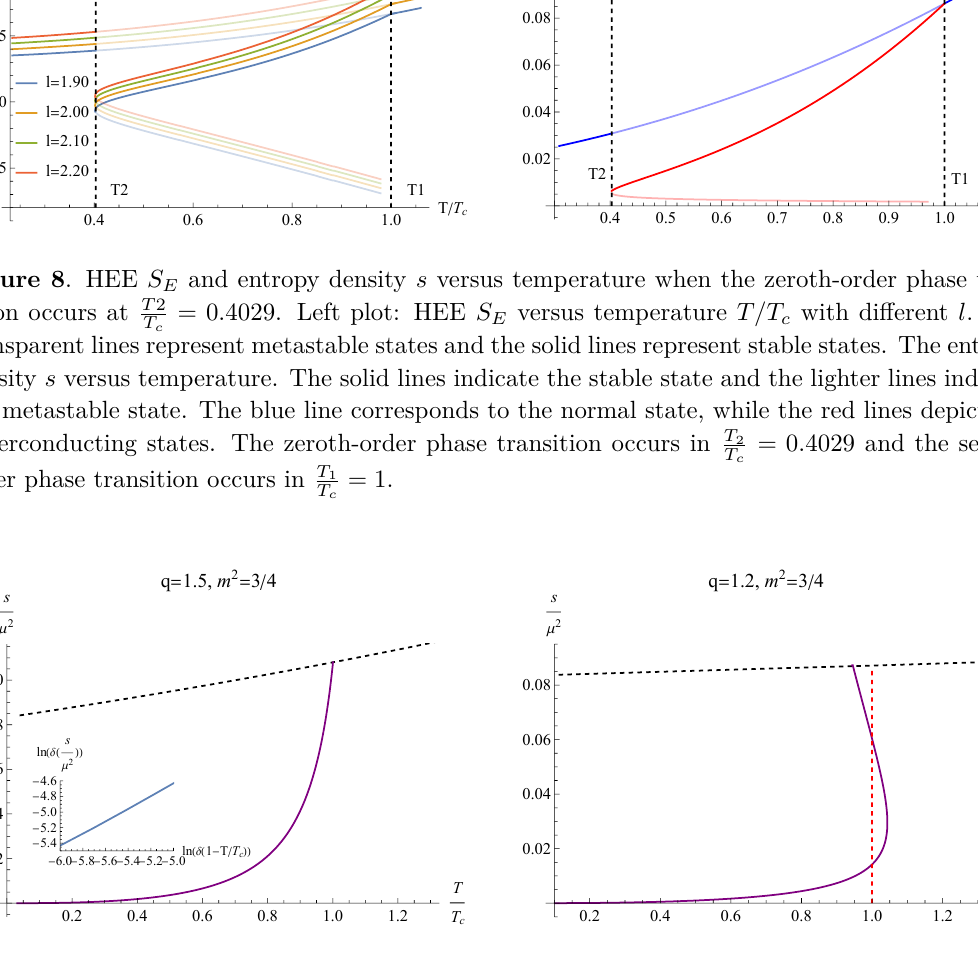
Figure 9 . The entropy density s vs temperature T/T c . The black dashed line represents the entropy density of the normal phase. The entropy density of the superconducting phase is represented by the purple line. Left plot: the second-order phase transition of holographic p-wave superconductor model. The inset plot depicts the logarithm between s and 1 − T . Right plot: the first-order phase T c transition of holographic p-wave superconductor model. The critical temperature is indicated by the red dashed